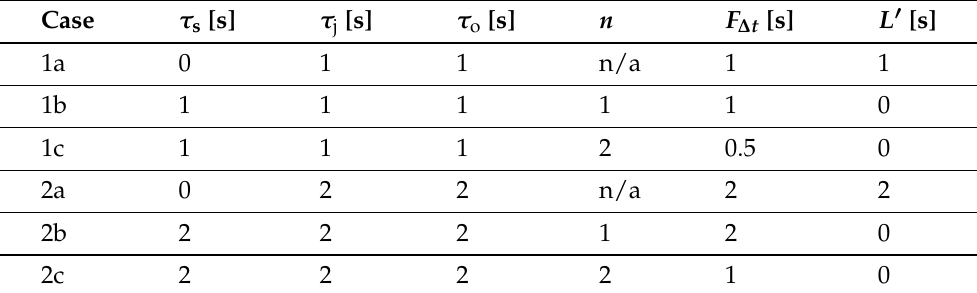
Table 3. Simulation parameters and their results in terms of video freeze and loss